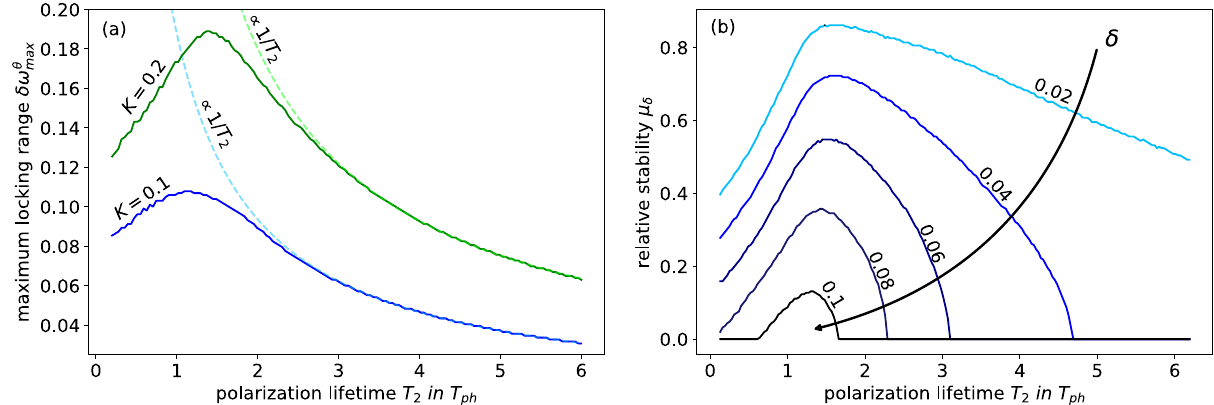
Figure 8. ( a ) Maximum locking range δω θ lock , i.e., the largest locking range δω lock on the interval [ 0, 2 π) θ , as a function of the polarization lifetime T 2 . The dashed lines are proportional to 1 / T 2 . Results are presented for K = 0.1 (blue) and K = 0.2 (green). ( b ) Relative locking stability µ δ defined in Eq. (10) as a function of the polarization lifetime T 2 for different δ (black line). Other parameters are �ω = 3 , p = 2 , K = 0.1 , τ = 10 and T = 392